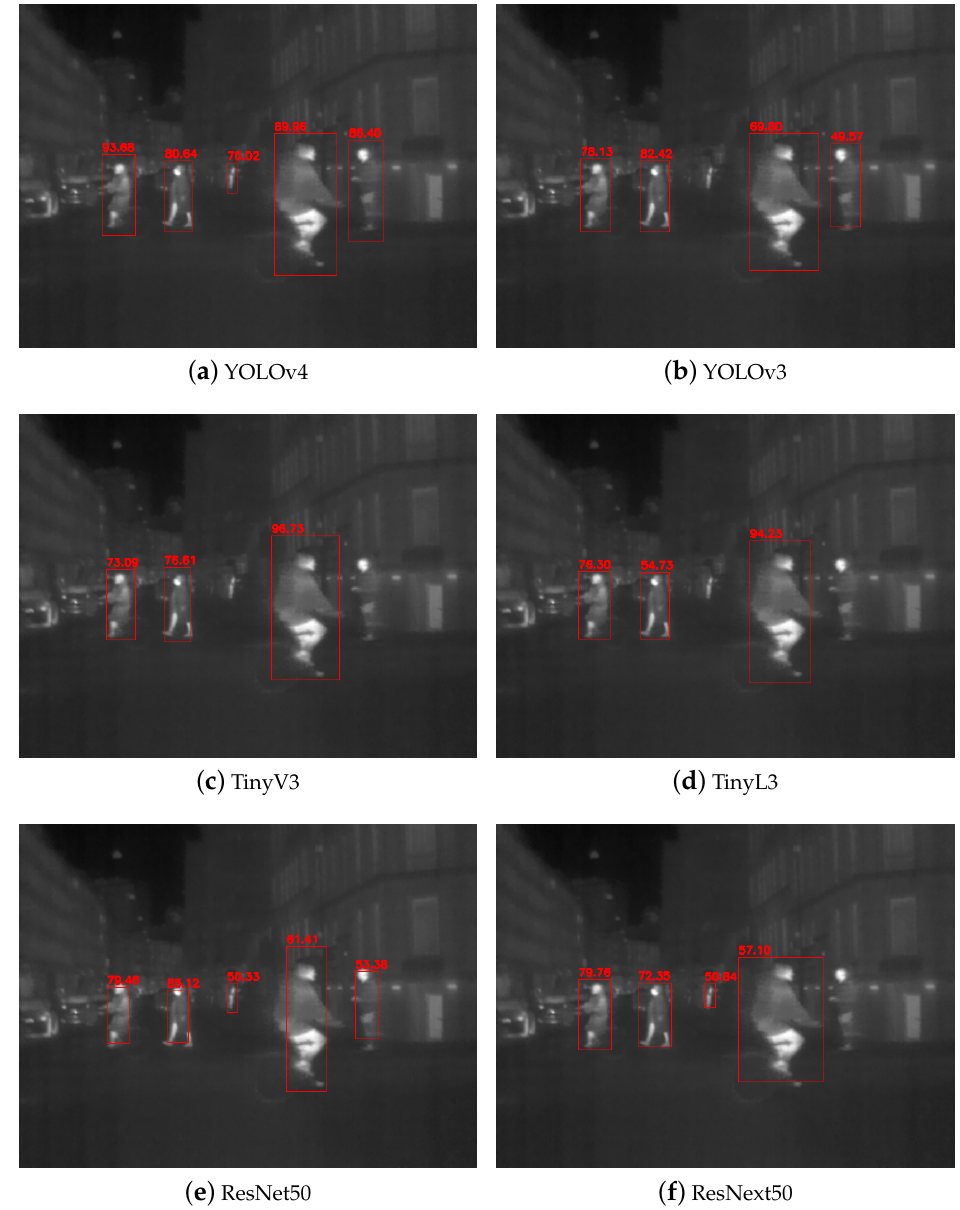
Figure 7. Comparison of detector performance before augmentation. Frame taken from ZUT dataset during the rain.